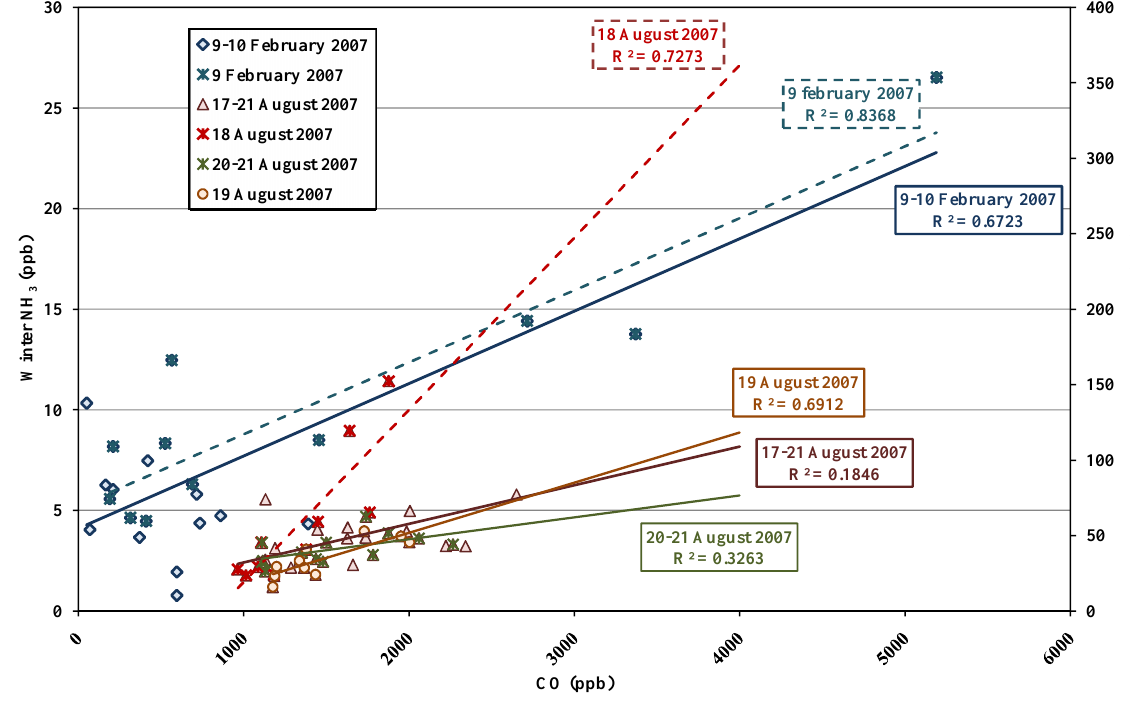
Fig. 6. Relationship between NH 3 and CO during the intensive winter and summer measurements.